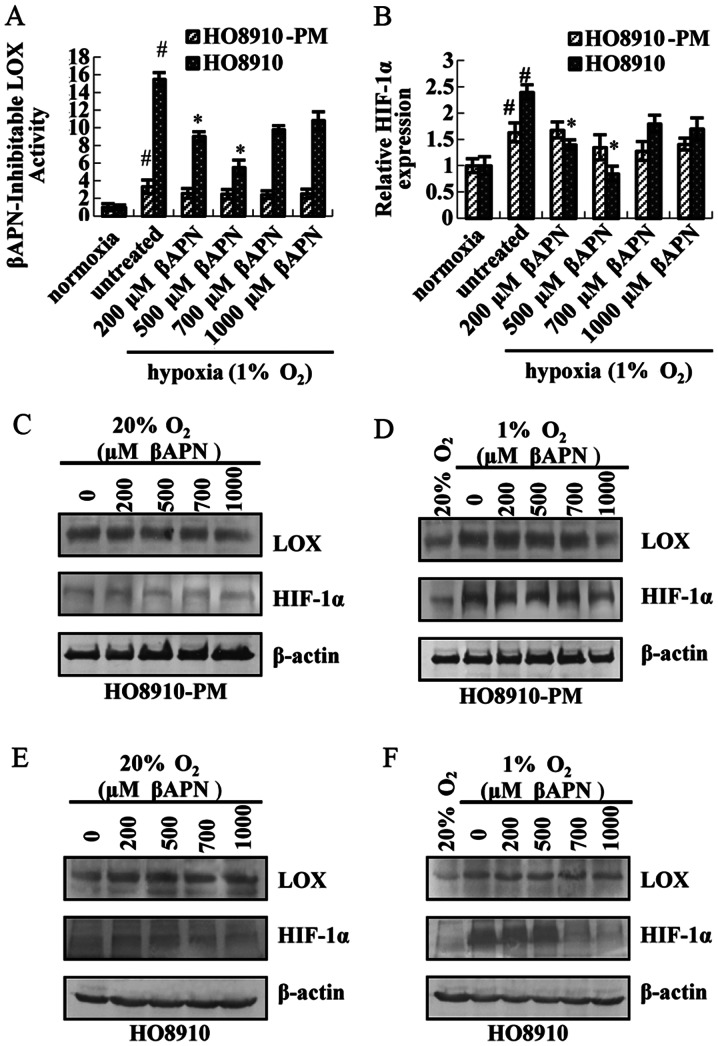
Effect of LOX catalytic activity on HIF-1α expression under hypoxic conditions. HO8910-PM and HO8910 cells were cultured under normoxia (20% O2), or hypoxia (1% O2) and exposed to different concentrations of βAPN (as indicated). (A) LOX activity (defined as βAPN-inhibitable hydrogen peroxide production) was measured using a commercial Lysyl Oxidase Activity Assay Kit. (B) Q-PCR analysis of HIF-1α mRNA expression; GAPDH was used as a reference gene. *P<0.05 vs. normoxic control cells and #P<0.05 vs. βAPN untreated hypoxic cells, ANOVA. Western blot analysis of LOX and HIF-1α protein expression in HO8910-PM cells cultured for 24 h in (C) 20% O2 or (D) 1% O2 in the absence or presence of increasing concentrations of βAPN. Western blot analysis of LOX and HIF-1α protein expression in HO8910 cells cultured for 24 h in (E) 20% O2 or (F) 1% O2 in the absence or presence of increasing concentrations of βAPN.